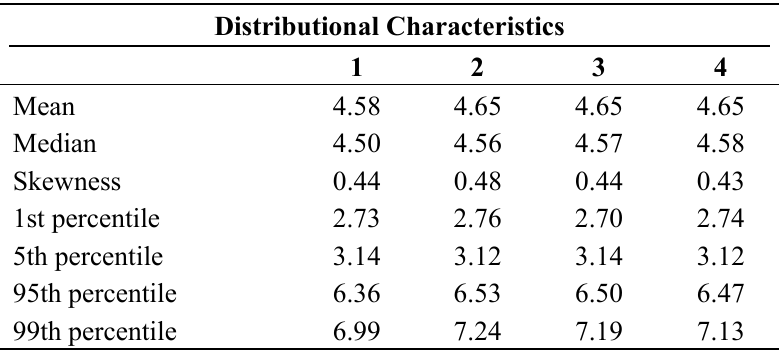
Table 4. Neighbourhood asthma prevalence (percentage rates).